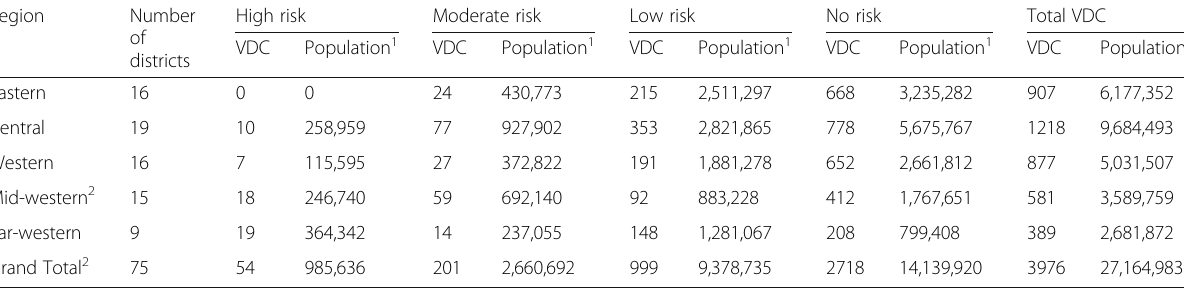
Table 3 Village Development Committees (VDCs) and risk population by development regions in Nepal